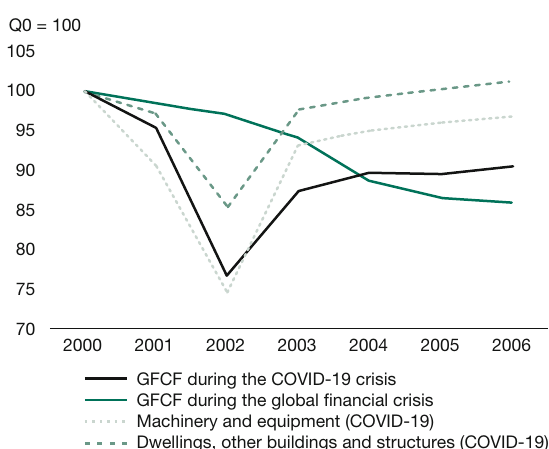
Figure 1 Gross fi xed capital formation and GDP in the euro area